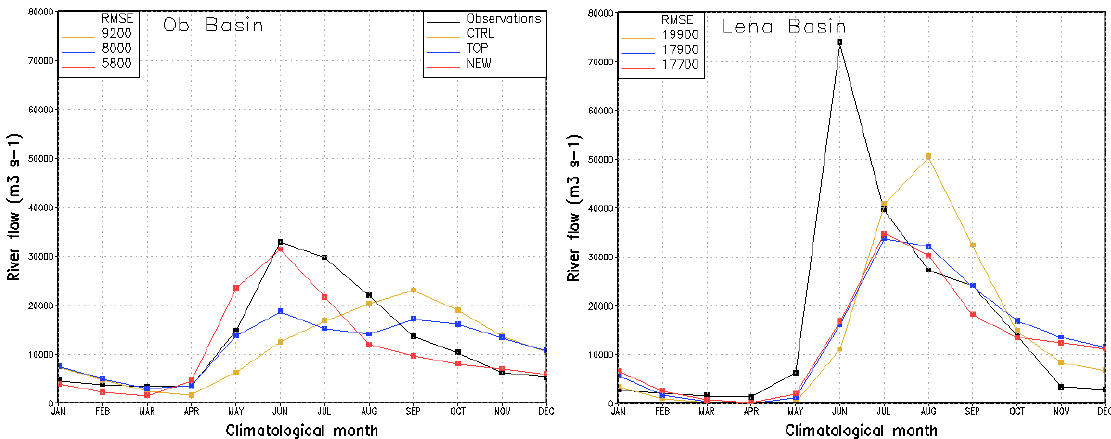
Fig. 9. Modelled river flow using Globsnow-factored driving snowfall data compared to observations. Scaling factors used were: 1.35 for the Ob and 1.7 for the Lena. The points represent the average flow rate for a given month. Each observational point is a climatological average value of 60 consecutive years in the range 1930–1999, depending on the basin. The model points are a climatological average value for the decade 1989–1999. The RMSE values are the yearly-average values for 3 significant figures.